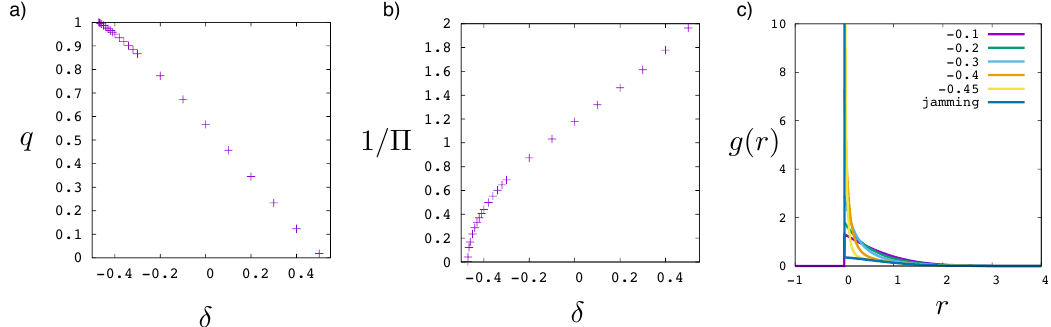
Figure 7: Glass phase of the hardcore model within the RS ansatz (here we choose α = 4): a) behavior of the order parameter q , b) inverse of the pressure Π , c) the distribution of the gap g ( r ) . The line labeled as jamming is for δ